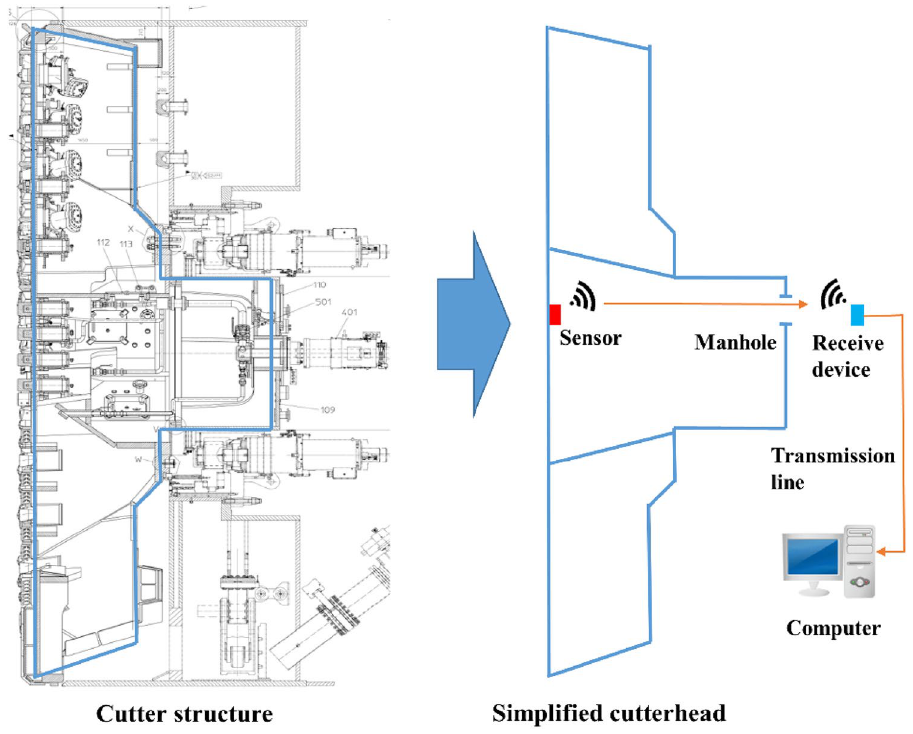
Figure 10. Cutterhead structure and signal transmission diagram (Generated by Auto CAD 2010 and Microsoft PowerPoints 2016).